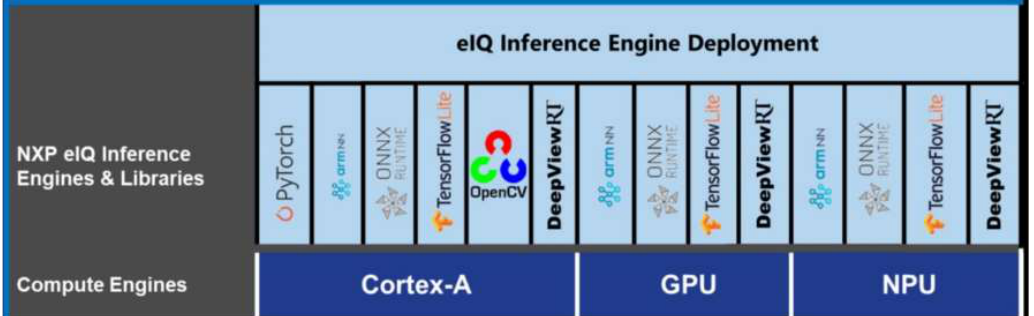
Figure 6. Inference Engines and libraries available for Neuronal Network Model Deployment for the NXP I.MX8M Plus platforms [77].